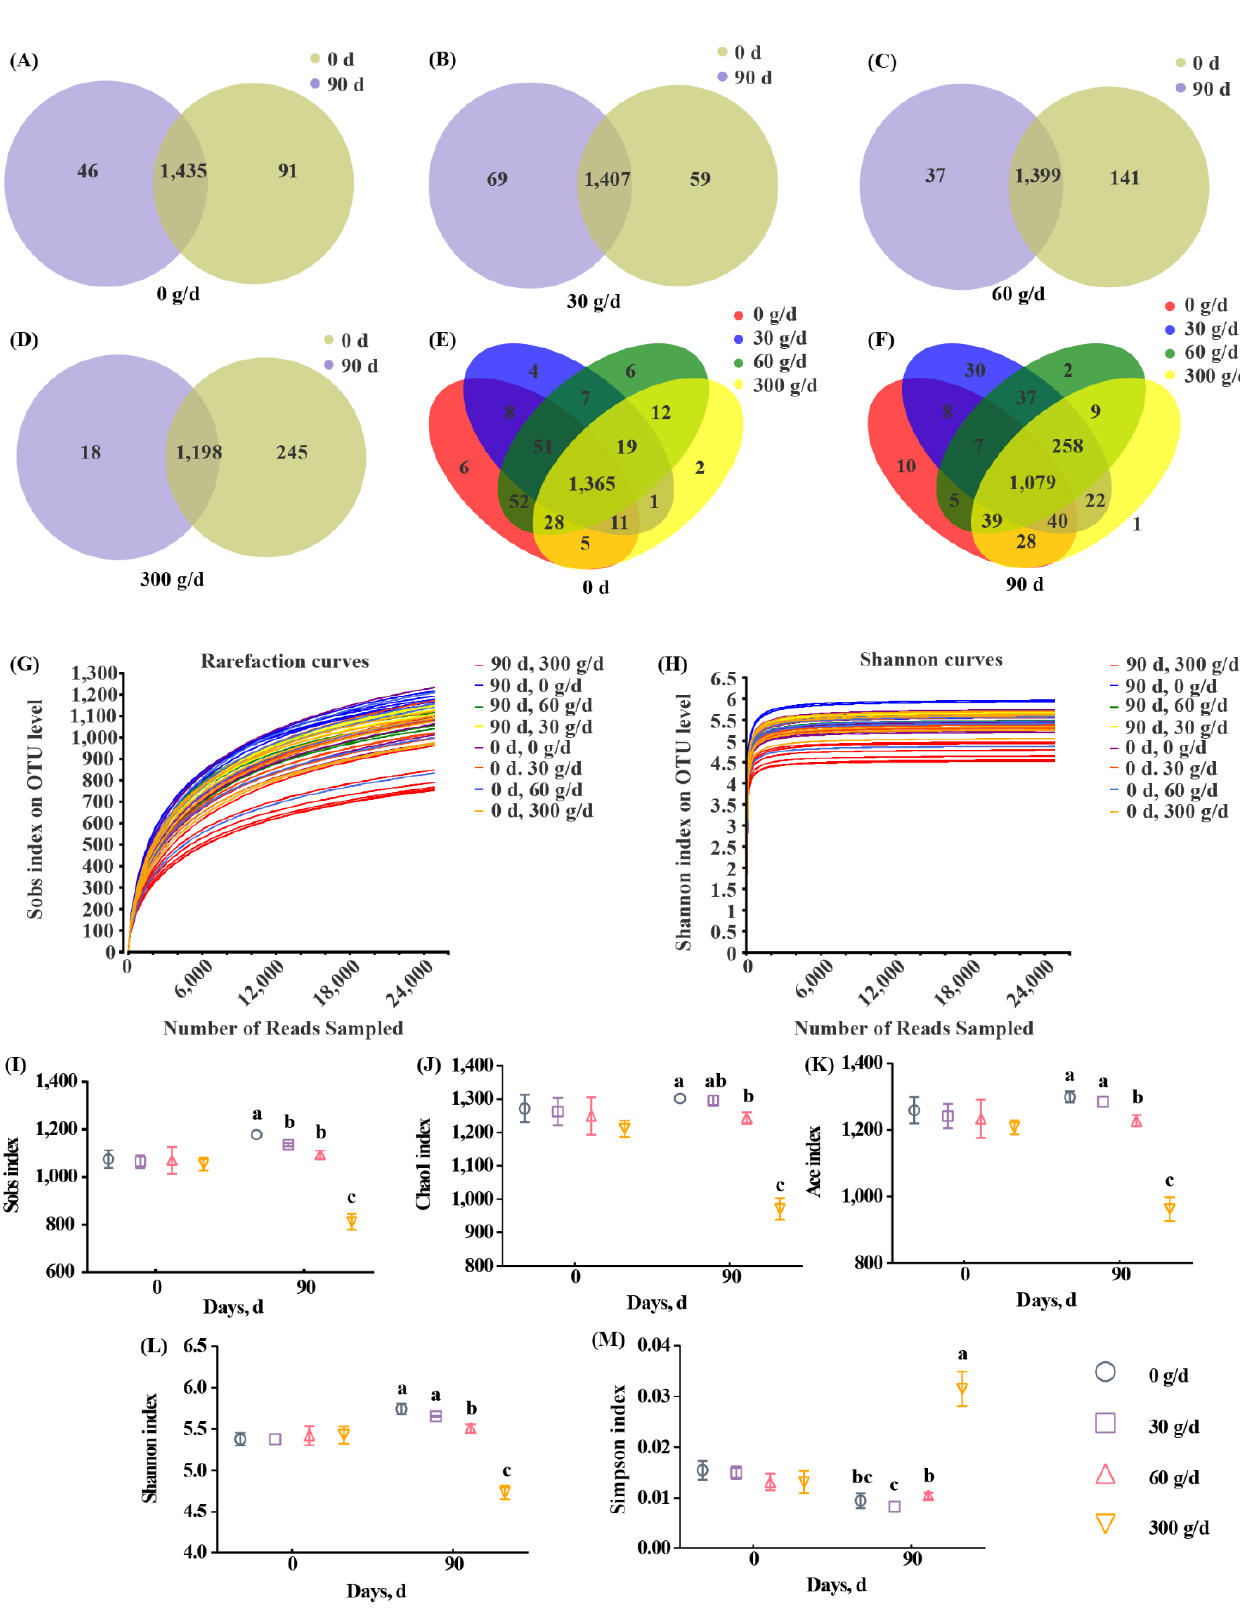
Figure 3. OTU number and alpha diversity responses of the ruminal microbiota to Acremonium terri- cola culture supplementation in lactating dairy cows. ( A – F ) Venn diagrams showing the number